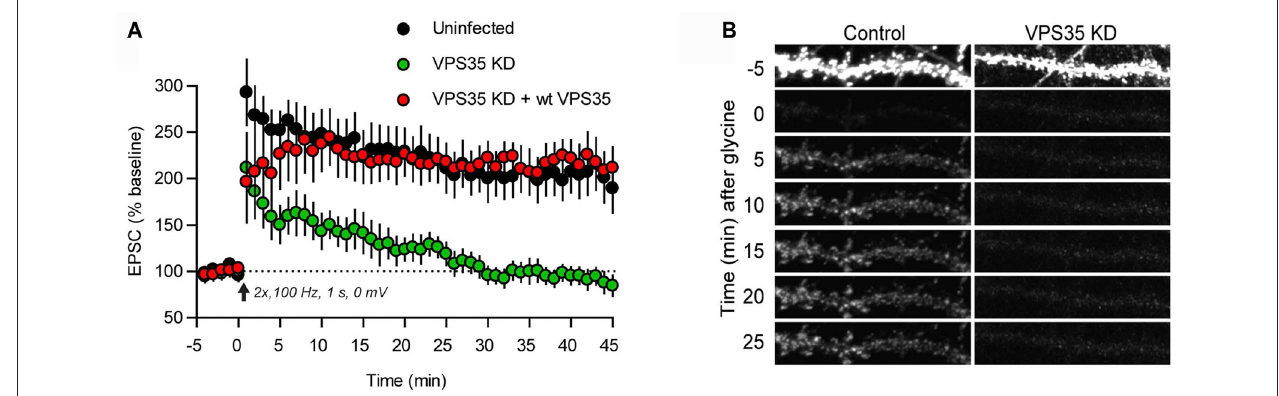
FIGURE 2 | Retromer supports AMPA receptor trafficking during long-term potentiation (LTP). (A) Plot of the excitatory postsynaptic current (EPSC) amplitude during induction of LTP in control hippocampal slices (black dots) and hippocampal slices infected with lentivirus expressing an shRNA for VPS35 (green dots), and a further control, in which VPS35 expression had been restored (red dots). (B) Induction of chemical LTP causes incorporation of GluA1 receptors (tagged with a pH-sensitive reporter) in the dendritic plasma membrane of a hippocampal control neuron (left). The dendrite was photobleached prior to LTP induction to reveal the successive accumulation of GluA1 receptors. Knockdown of VPS35 (right) effectively inhibited receptor incorporation (reproduced from Temkin et al., 2017 with